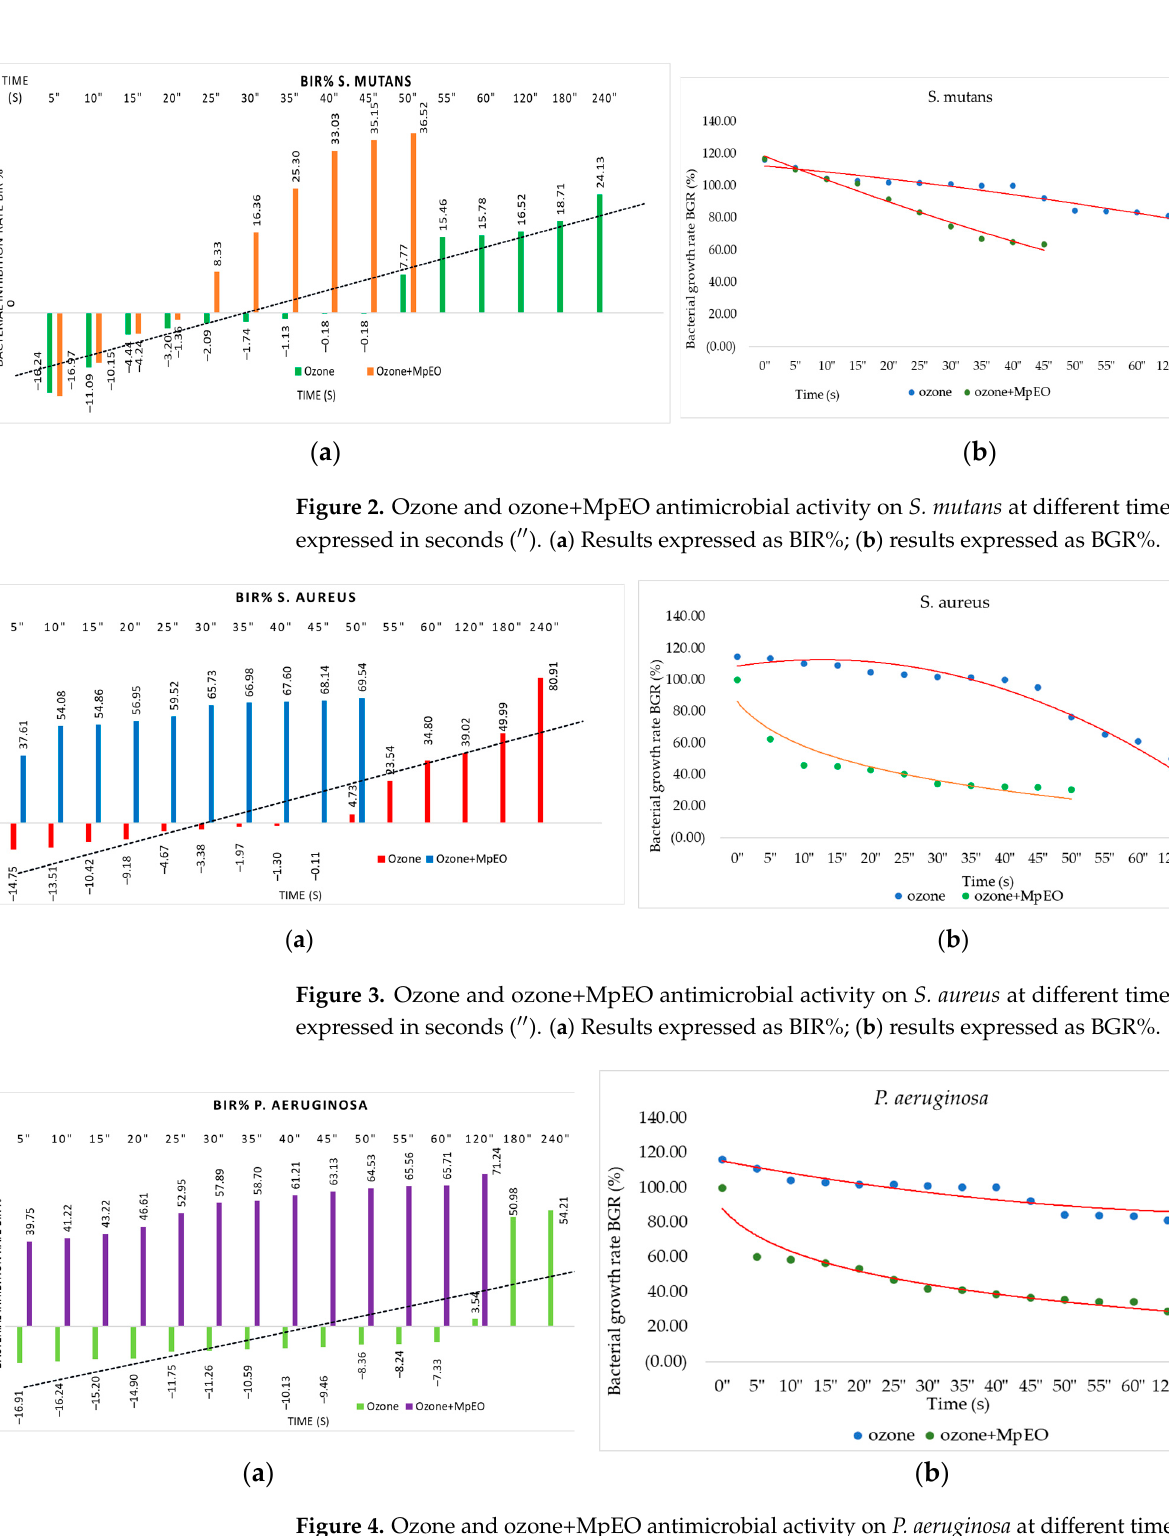
Figure 5. Ozone and ozone+MpEO antimicrobial activity on E. coli at different time exposures ex- pressed in seconds ( ″ ). ( a ) Results expressed as BIR%; ( b ) results expressed as BGR%.